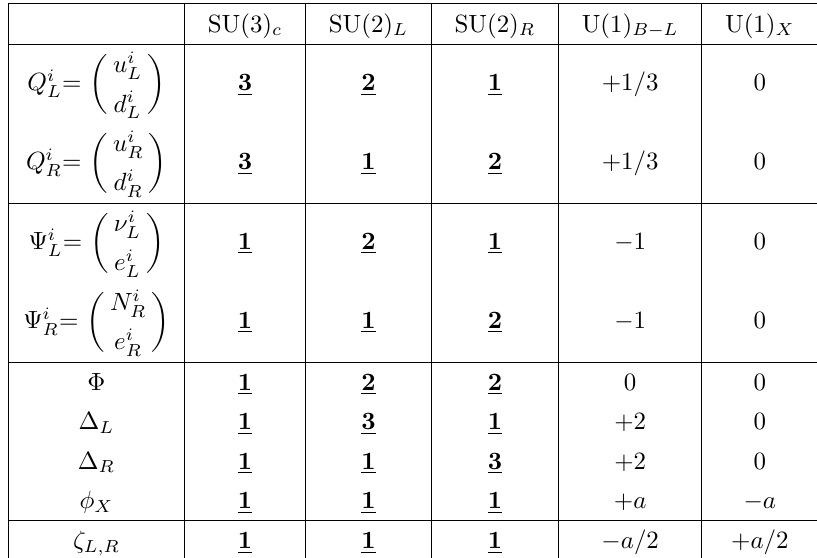
The particle content of our minimally extended LRSM with Majorana fermion DM. Along with the U(1) X gauge symmetry, a new scalar φ X and a vector-like pair of the fermions ζ L,R are introduced. All fields in the original LRSM are singlet under the U(1) X . i = 1 , 2 , 3 is the generation index, and a 6 = 0 is a real